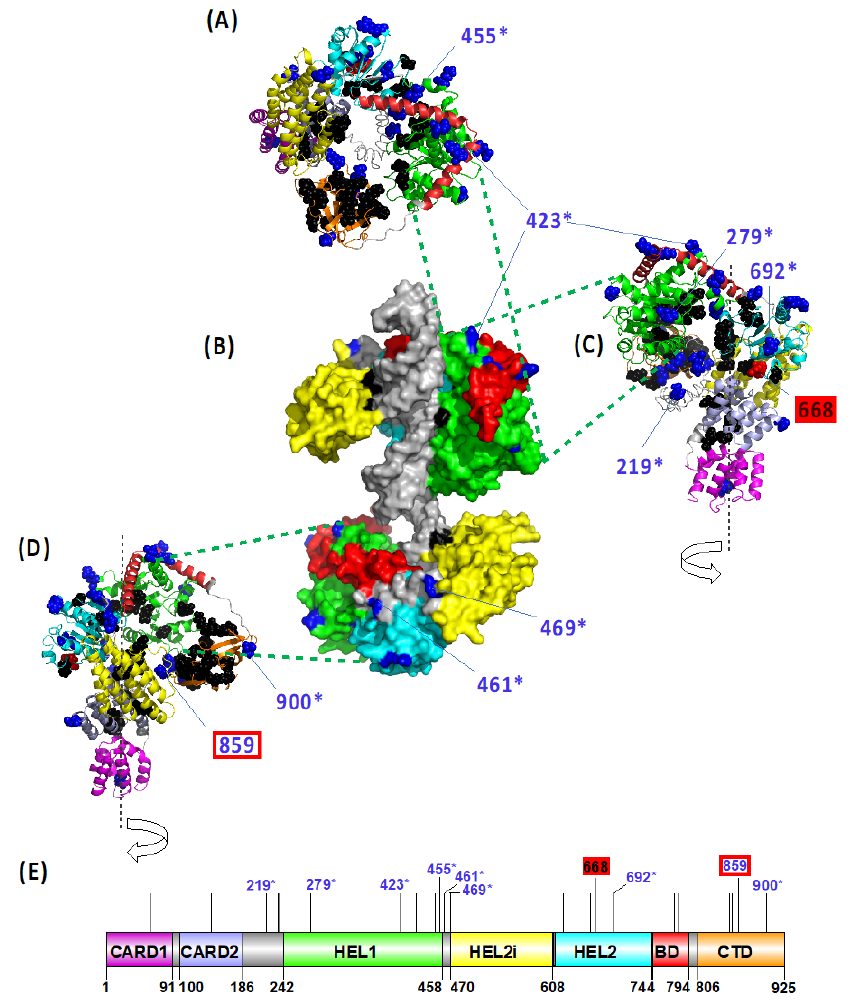
Figure 4. Topological distribution of the avian RIG-I positively selected sites (PSSs) in the protein structural model. Three-dimensional model of duck RIG-I is shown in its open state (ribbon models: ( A )—top view, ( C )—right-hand view, and ( D )—left-hand view) and in a closed state with the ligand dsRNA bound ( B ). PSSs are also plotted on a linear scheme of a duck RIG-I domain structure ( E ). Previously reported functionally important residues are highlighted in black. PSSs are shown in